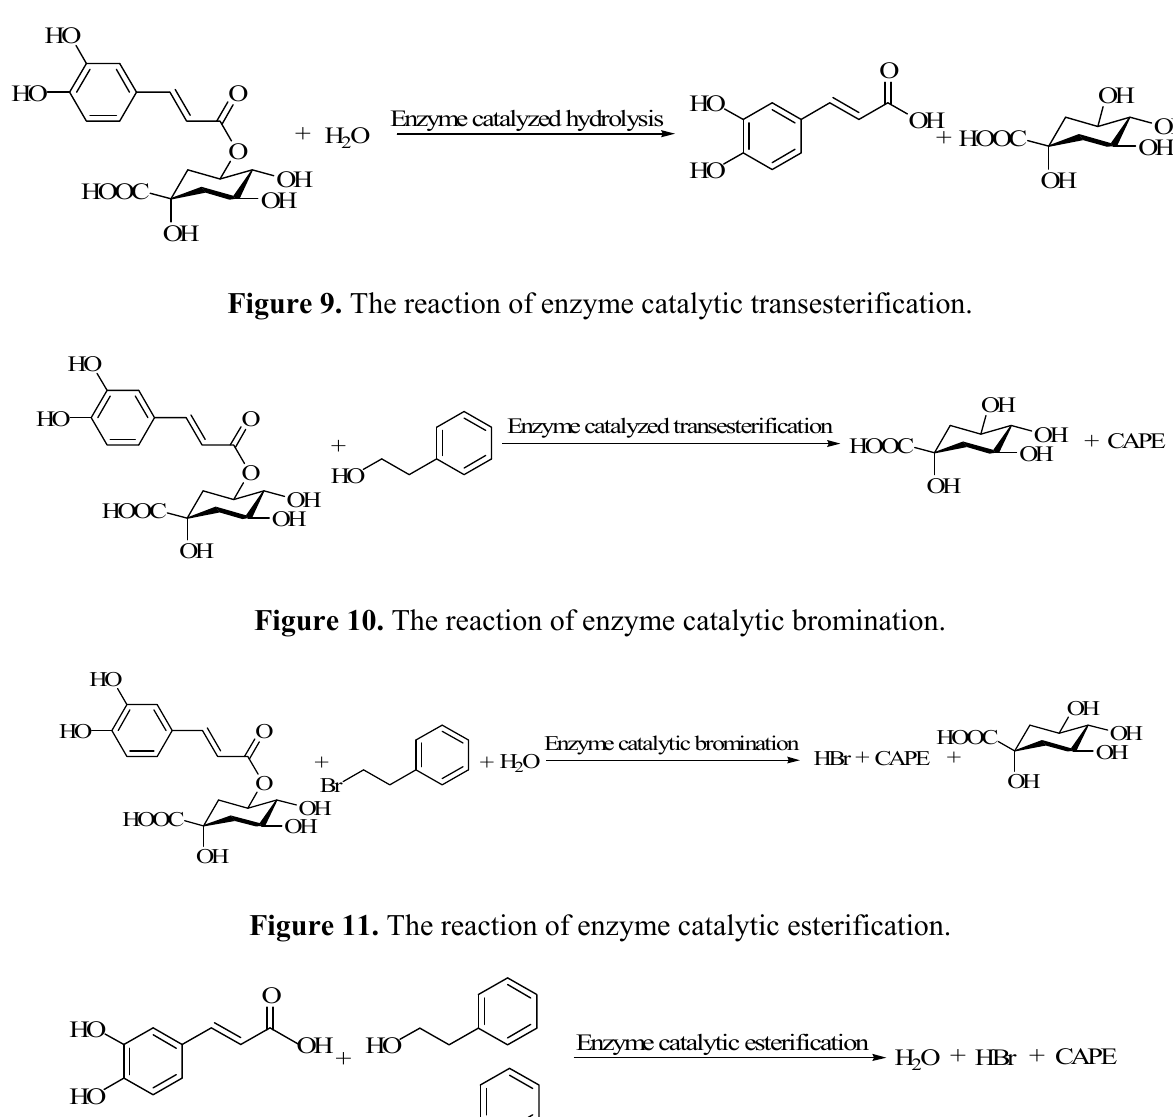
Figure 10. The reaction of enzyme catalytic bromination.